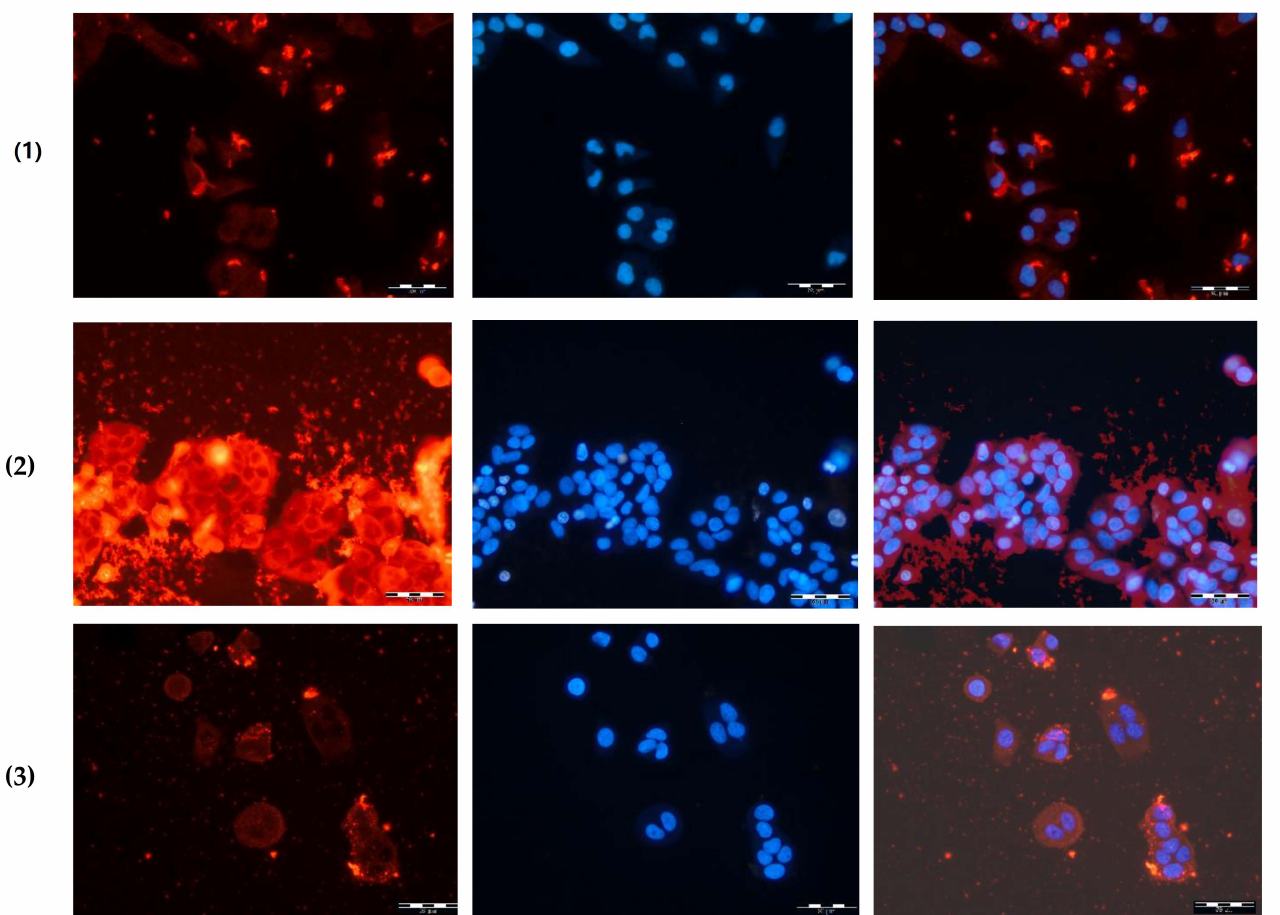
Figure 8. Fluorescent images of A549 cells treated with Cy 3 -labeled NPs: ( 1 ) PMAG- b -P(Lys- co -Phe), sample #1.5, ( 2 ) P(Lys- co - D -Phe), sample #2.1 and ( 3 ) (P(Lys- co - D -Phe)-HEP, sample #3.1 for 4 h ( C NPs = 60 µ g/mL). Images from left to right show Cy 3 -labeled nanoparticles in cells (red), cell nuclei stained by DAPI (blue), and overlays of two images ( × 20). Scale bar: 50 µ